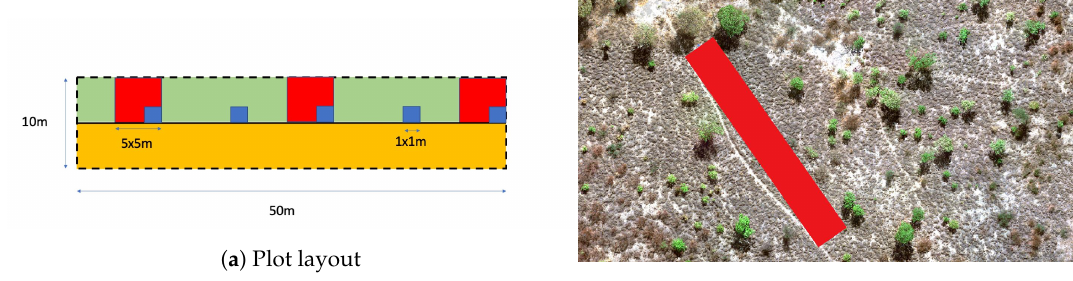
Figure 5. An example individual ( a ) plot schematic and ( b ) location with an UAS-generated orthophoto showing how AGB was measured for the various fuel classes. In ( a ), blue squares show locations where grass and litter were collected, and red squares for coarse woody debris. Heavy fuels were measured in the green half of the plot, shrubs counted within 1m of the centre line in the yellow half and trees counted in the whole yellow